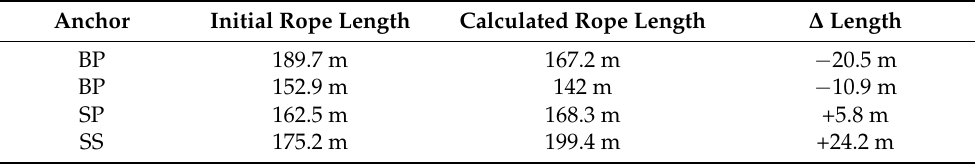
Table 5. Current length of individual anchor ropes and determined length of anchor